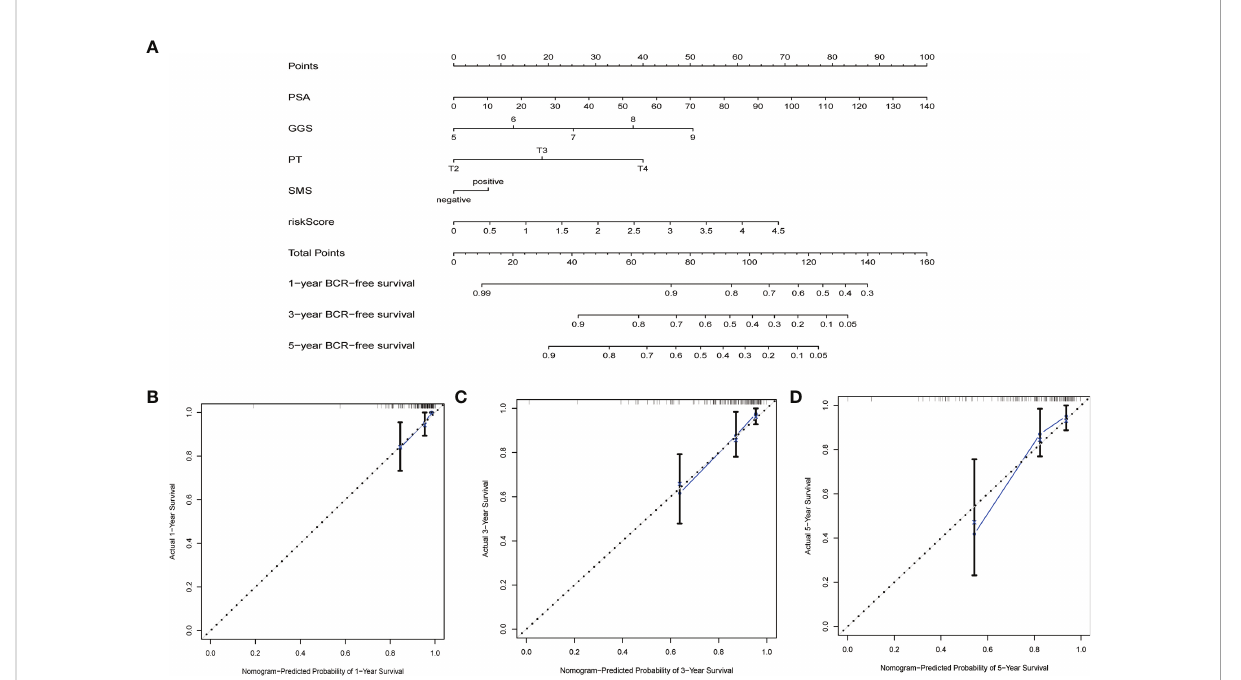
FIGURE 6 Nomograms and calibration plots based on the characteristics and clinical variables we established. (A) Probabilistic nomogram for predicting 1-, 3-, and 5-year biochemical recurrence-free survival in patients with localized prostate cancer; (B – D) Columnar line plot calibration plots for consistency tests between 1-, 3-, and 5-year survival predictions and actual